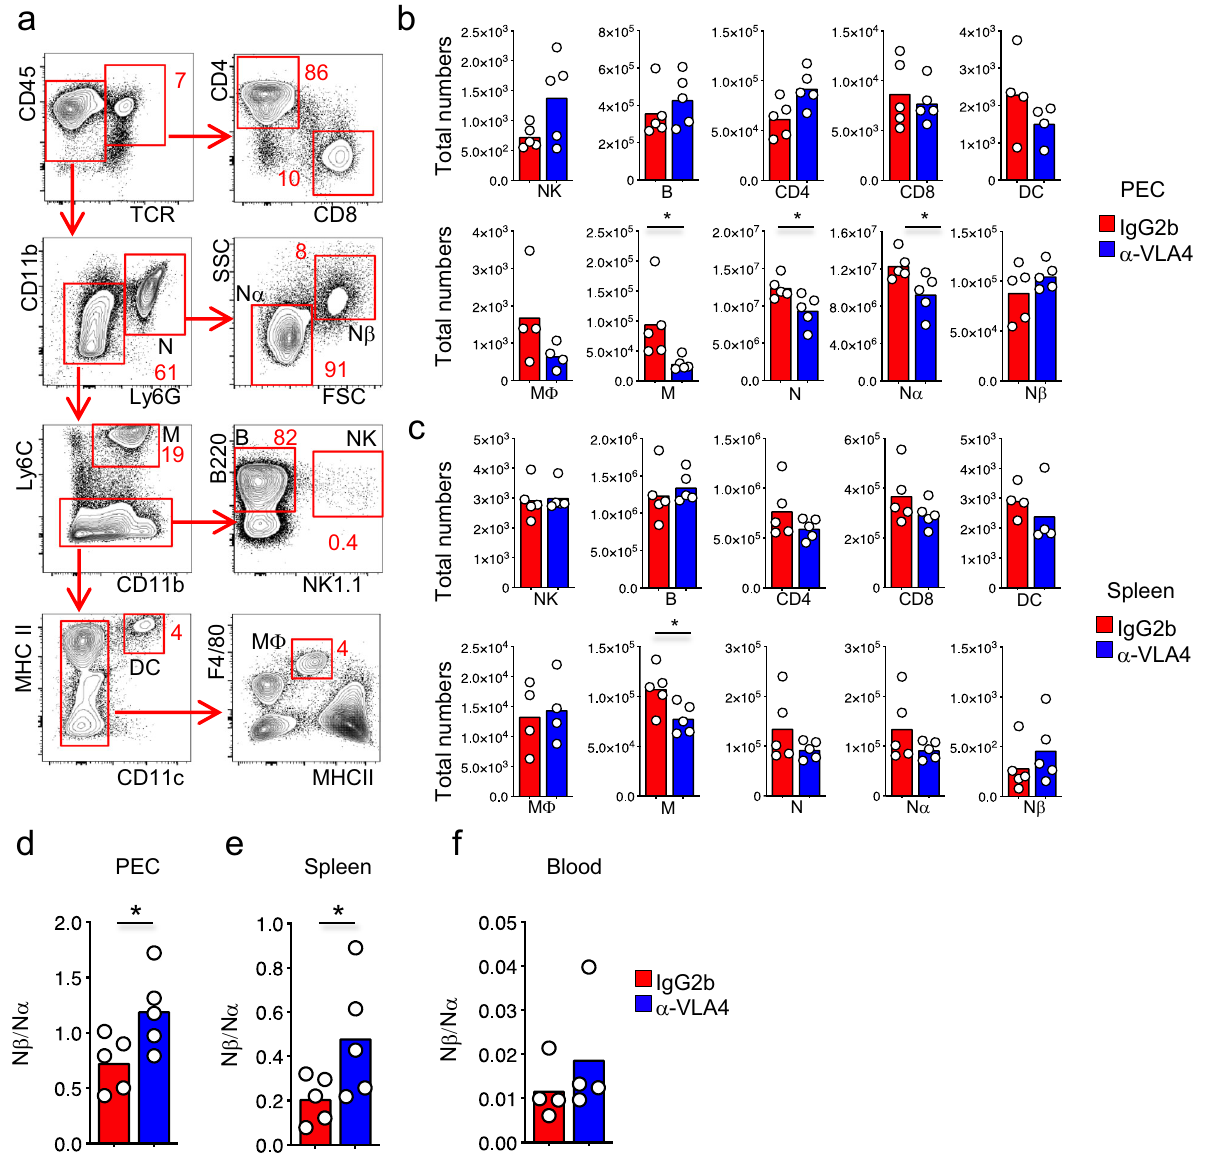
Fig. 5 Inhibition of VLA-4 increases N β /N α ratio. Contour plot composition of peritoneal immune in fi ltrate after NYVAC-C Δ 3 infection. Proportion of TCR + CD4 + and TCR + CD8 + T cells, CD11b + Ly6G + neutrophils divided by SSC and FSC in N α and N β , CD11b + Ly6G − Ly6C + monocytes (M), B220 + NK1.1 − B cells, NK1.1 + NK cells, MHCII + CD11c + dendritic cells (DC) and F4/80 + MHCII + macrophages (M Φ ) were measured at 6 h post infection ( a ). Total numbers of NK, B, CD4, CD8, DC, M Φ , M, N, N α , and N β from PEC ( b ) and spleen ( c ) of NYVAC-C Δ 3 infected and IgG2b or anti-VLA4 antibody-treated mice. Mice were injected with IgG2b isotype or anti-VLA4 antibody 16 h before- and 1 h post infection. N β /N α ratio from PEC ( d ), spleen ( e ), and blood ( f ) of infected and IgG2b or anti-VLA4 antibody-treated mice. Graphs show mean; each point represents an individual mouse. Data are representative of two independent experiments. * P <